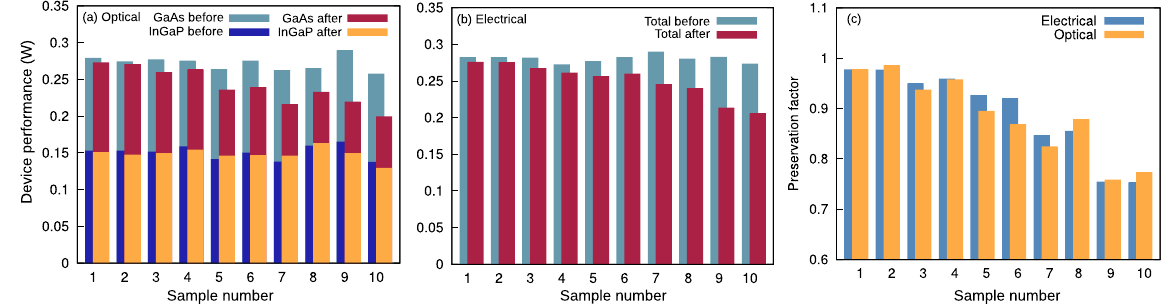
sample by dividing the maximum output power after irradiation by that before irradiation. Values close to unity mean that the sample suffered almost no damage. The preservation factors predicted using the time-resolved method are very close to the electrically measured factors, within 5%. This confirms that the optical technique presented in this work is an excellent tool to analyze the electrical conversion efficiencies of the subcells.